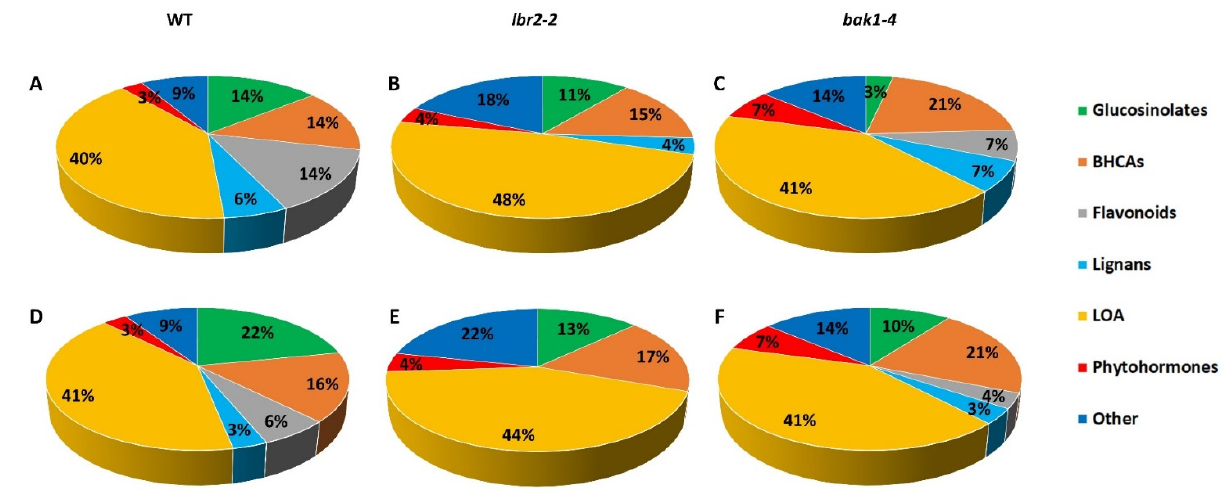
Figure 3. LPS-induced discriminant metabolite classes identified in Arabidopsis WT and mutant ( lbr2-2 and bak1-4 ) lines (Table 1). ( A – C ) represents discriminant metabolites from LPS Pst -treated WT, lbr2-2 and bak1-4 , respectively. ( D – F ) represents discriminant metabolites from LPS Xcc -treated WT, lbr2-2 and bak1-4 , respectively. These metabolites contribute to the defence response in Ara- bidopsis WT and mutants. Abbreviations: BHCAs = benzoic- and hydroxycinnamic acid derivatives; LOA = lipids, oxylipins and arabidopsides.